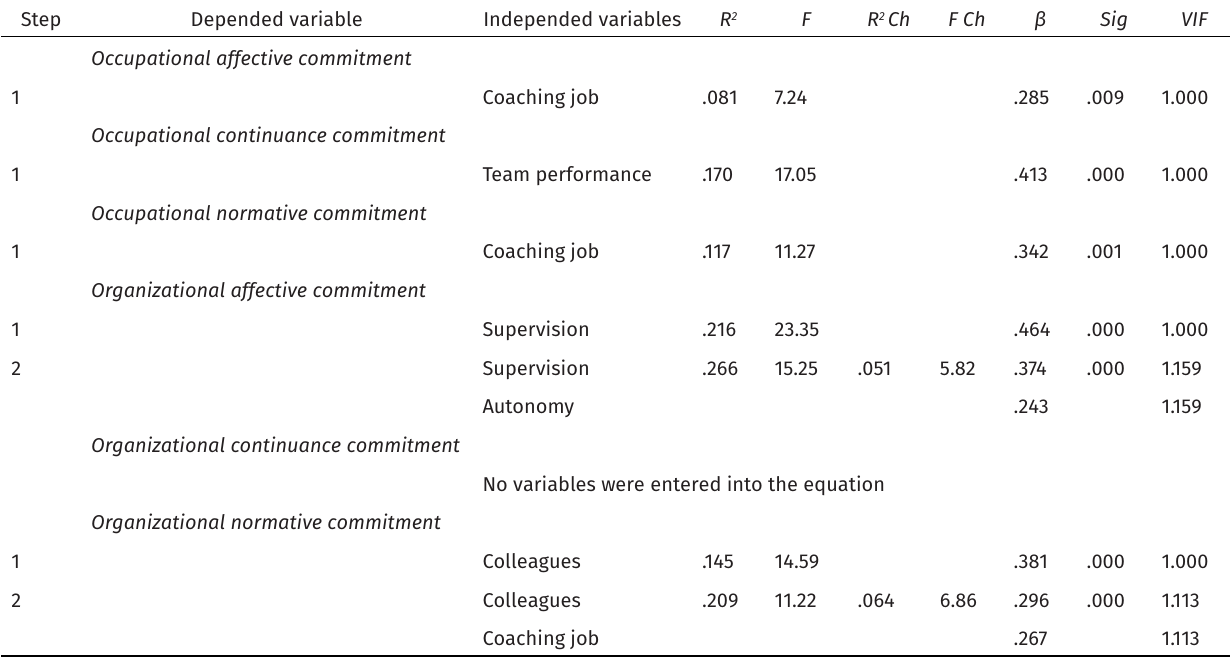
Table 3. Stepwise regression analyses of commitment